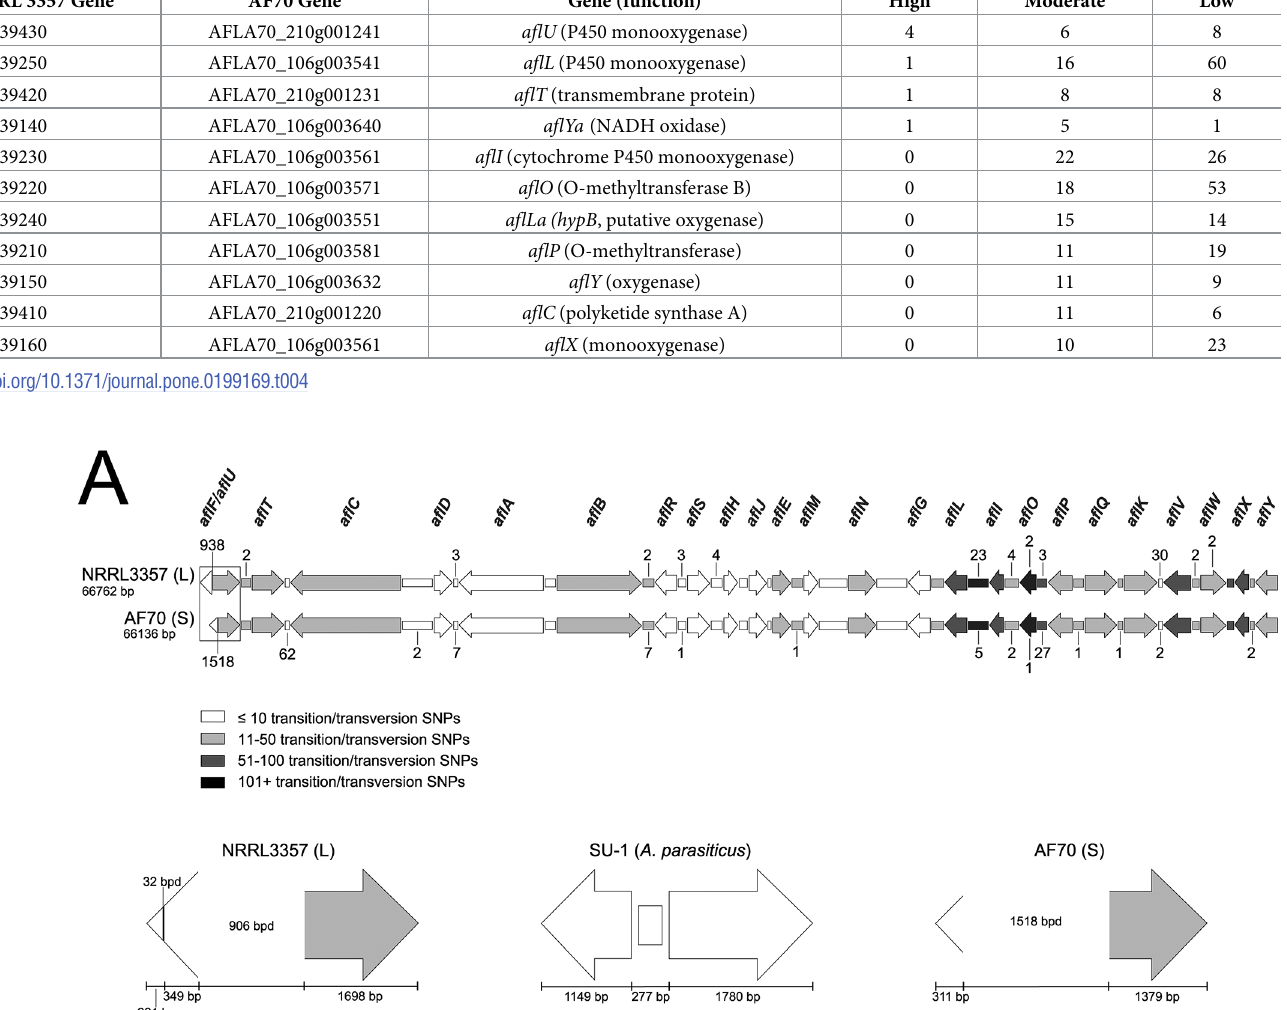
Table 4. Genes in the aflatoxin biosynthetic cluster with SNP impacts classified as high, moderate, or low impact. NRRL 3357 Gene